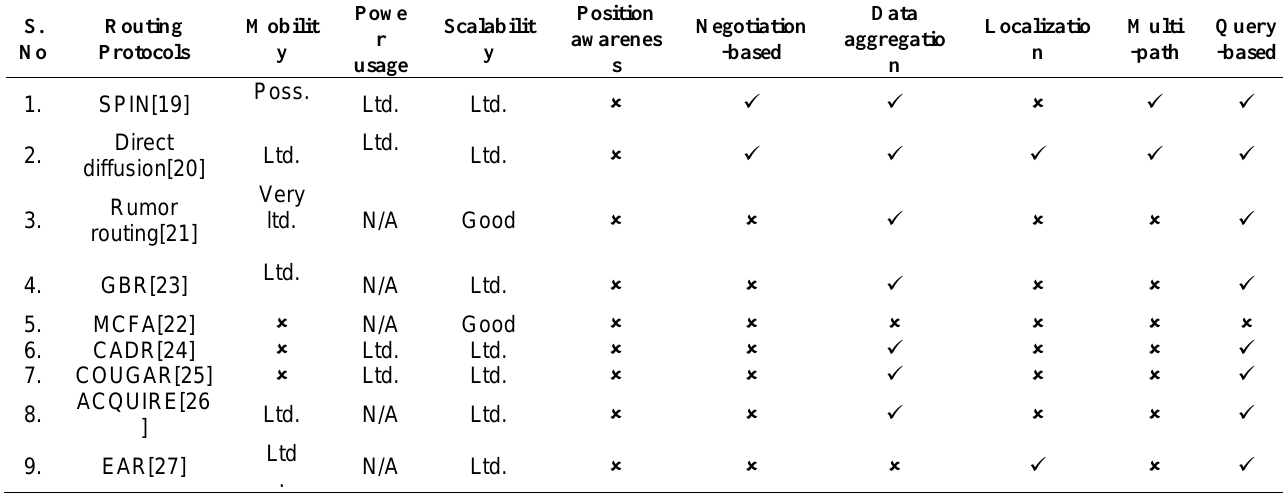
Table 2. Classification of flat network based routing